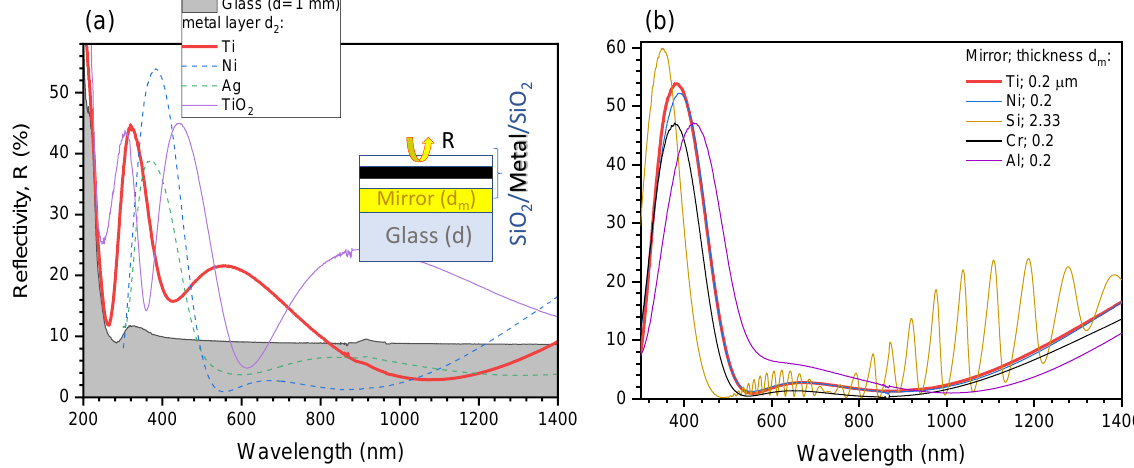
Figure 5. ( a ) Reflection spectra for various d 2 materials when d 2 = 7.9 nm. A soda lime substrate reference spectra in shown in background; ( b ) reflection spectra for a Ni d 2 layer with various metals substituted in the mirror layer of d m = 200 nm; for silicon (from a silicon on insulator substrate), d m ≈ 2.33 µm. The thickness evaluated from two interference peaks λ 1 = 974.74 nm and λ 2 = 1037.11 nm is d m = λ 1 λ 2 calculated for the refractive index n = 3.673